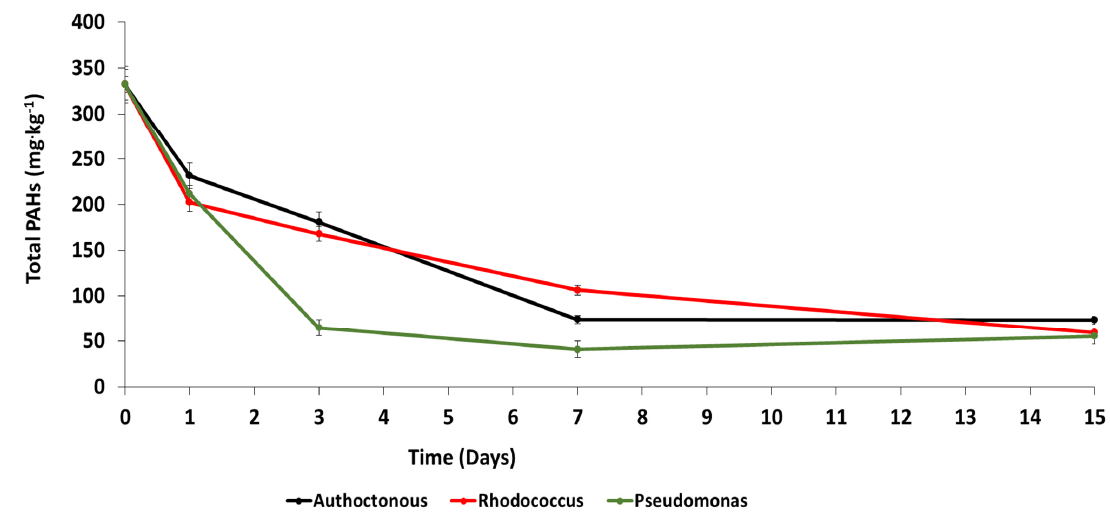
Figure 3. Evolution of the total polycyclic aromatic hydrocarbon (PAH) concentration during the bioslurry reactor experiments.